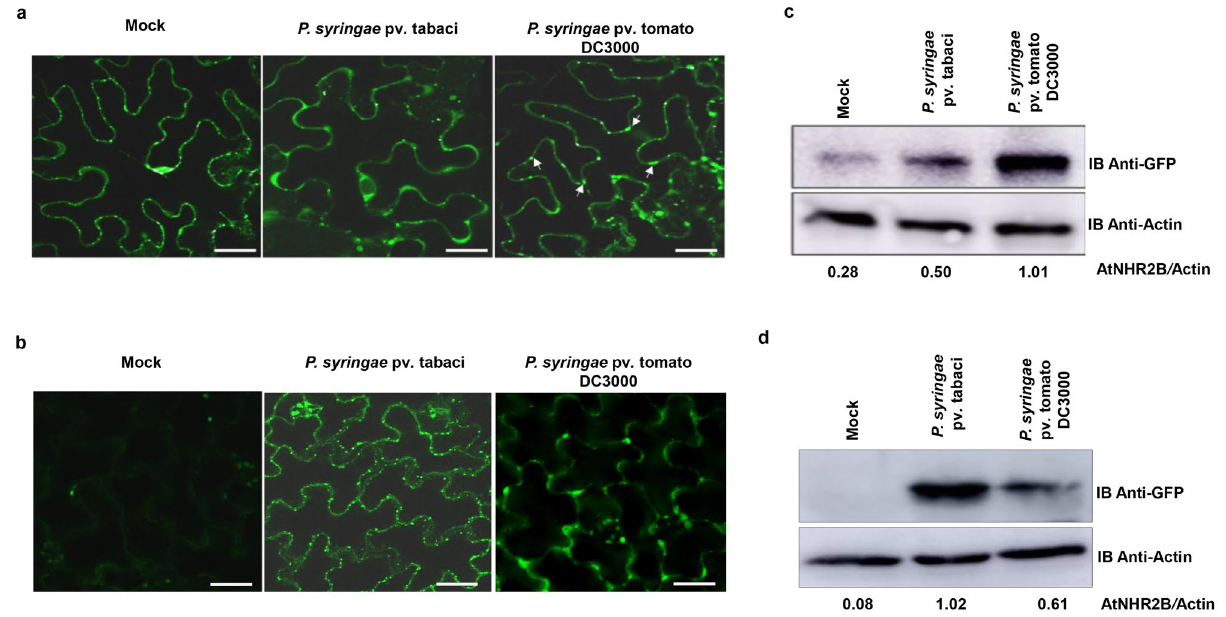
Figure 1. Adapted pathogens interfere with AtNHR2B-GFP localization and protein abundance. ( a ) The host adapted pathogen Pstab alters AtNHR2B-GFP localization. N. benthamiana plants transiently expressing AtNHR2B-GFP were infiltrated with water (mock), or inoculated with either the adapted pathogen Pstab or the non-adapted pathogen Pst DC3000 at 1 × 10 6 CFU/ml . Treated leaf samples were collected after 24 hpi and imaged by laser scanning confocal microscopy. Confocal images were taken at ×20 magnification and using an excitation and emission wavelengths of 488 nm and 500–535 nm, respectively. White arrows show punctate bodies. Scale bar = 10 µm. ( b ) The host adapted pathogen Pst DC3000 alters AtNHR2B-GFP localization in Arabidopsis. Arabidopsis transgenic plants expressing AtNHR2B-GFP were mock-treated or inoculated with the adapted pathogen Pst DC3000 and the non-adapted pathogen Pstab at 1 × 10 6 CFU/ml . Treated leaf samples were collected after 24 hpi and imaged by laser scanning confocal microscopy. Confocal images were taken at ×20 magnification and using an excitation and emission wavelengths of 488 nm and 500–535 nm, respectively. White arrows show punctate bodies. Scale bar = 10 µm. ( c ) The host adapted pathogen Pstab alters AtNHR2B- GFP protein abundance in tobacco plants. N. benthamiana plants transiently expressing AtNHR2B-GFP were infiltrated with water (mock) or inoculated with either the adapted pathogen Pstab or the non-adapted pathogen Pst DC3000 as described for ( a ). Treated leaf samples were collected after 24 hpi to evaluate protein abundance by Western blot using anti-GFP and anti-actin antibodies. Protein quantification was done by ImageJ software (http:// rsb. info. nih. gov/ ij/), using actin signal for normalization. Number below the protein bands represent the AtNHR2-GFP/Actin ratios. ( d ) The host adapted pathogen Pst DC3000 alters AtNHR2B-GFP protein abundance in Arabidopsis plants. A. thaliana transgenic plants expressing AtNHR2B-GFP were infiltrated with water (mock), or inoculated with either the adapted pathogen Pst DC3000 or the non-adapted pathogen Pstab as described for ( b ) . Treated leaf samples were collected after 24 hpi to quantify protein abundance by Western blot using anti-GFP and anti-Actin antibodies. Protein quantification was done as described for ( c results suggest that the Atnhr2b mutation restores the growth defect in the PstDC3000 Δ hopG1 mutant support- ing a functional relationship between HopG1 and AtNHR2B.